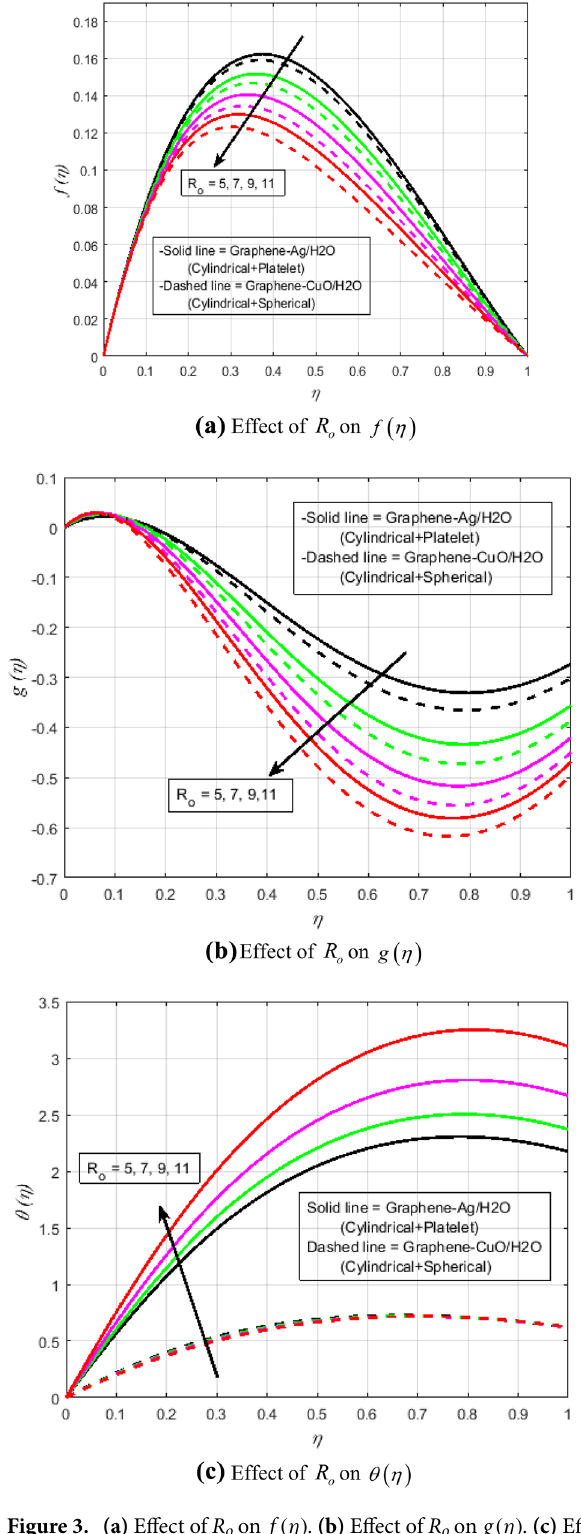
Figure 3. (a) Effect of R o on f (η) . (b) Effect of R o on g (η) . (c) Effect of R o on θ(η)